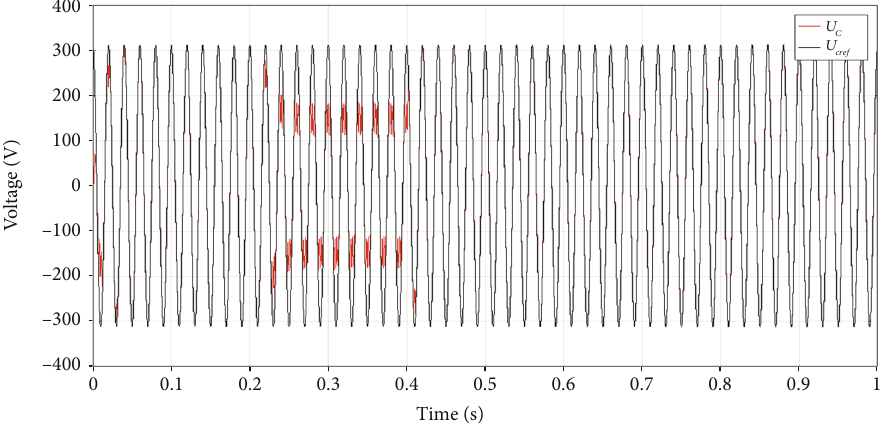
Figure 18: Output voltage inverter after fi ltering with its